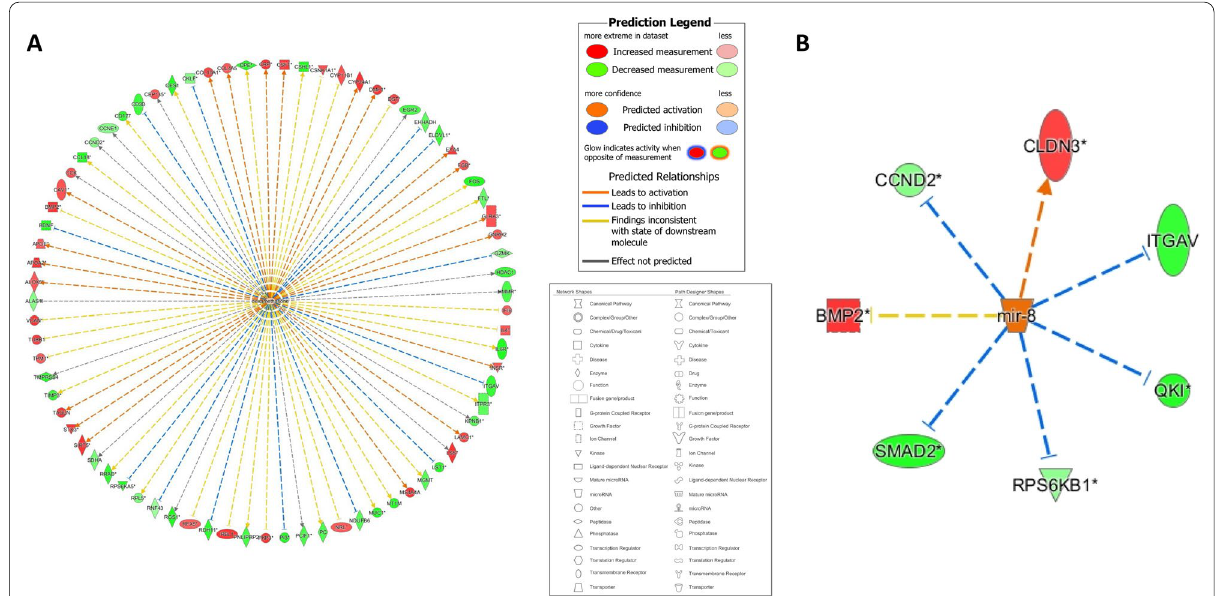
Fig. 5 Upstream regulators dexamethasone and miR‑8. A Chemical drug dexamethasone is predicted to be activated in smoker buccal mucosa with P value 1.10 10 –06 and Z score 0.438. B miR‑8 is predicted to be activated in smoker buccal mucosa with P value = × = score 2.1. Different shapes represent the molecular class of the protein. Red and green indicate upregulation and downregulation, respectively, = while blue and orange indicate inhibition and activation, respectively. A solid line indicates a direct interaction, a dashed line indicates an indirect interaction, and a dotted line indicates inferred correlation from machine‑based learning. An asterisk indicates that multiple identifiers in the dataset file map to a single gene or chemical in the Global Molecular Network